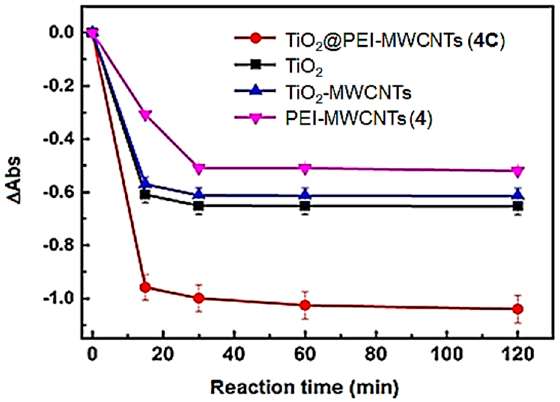
Figure 11. Time course of UBA bleaching monitored at 587 nm. Data are reported as mean value of three replicates ± standard deviation.